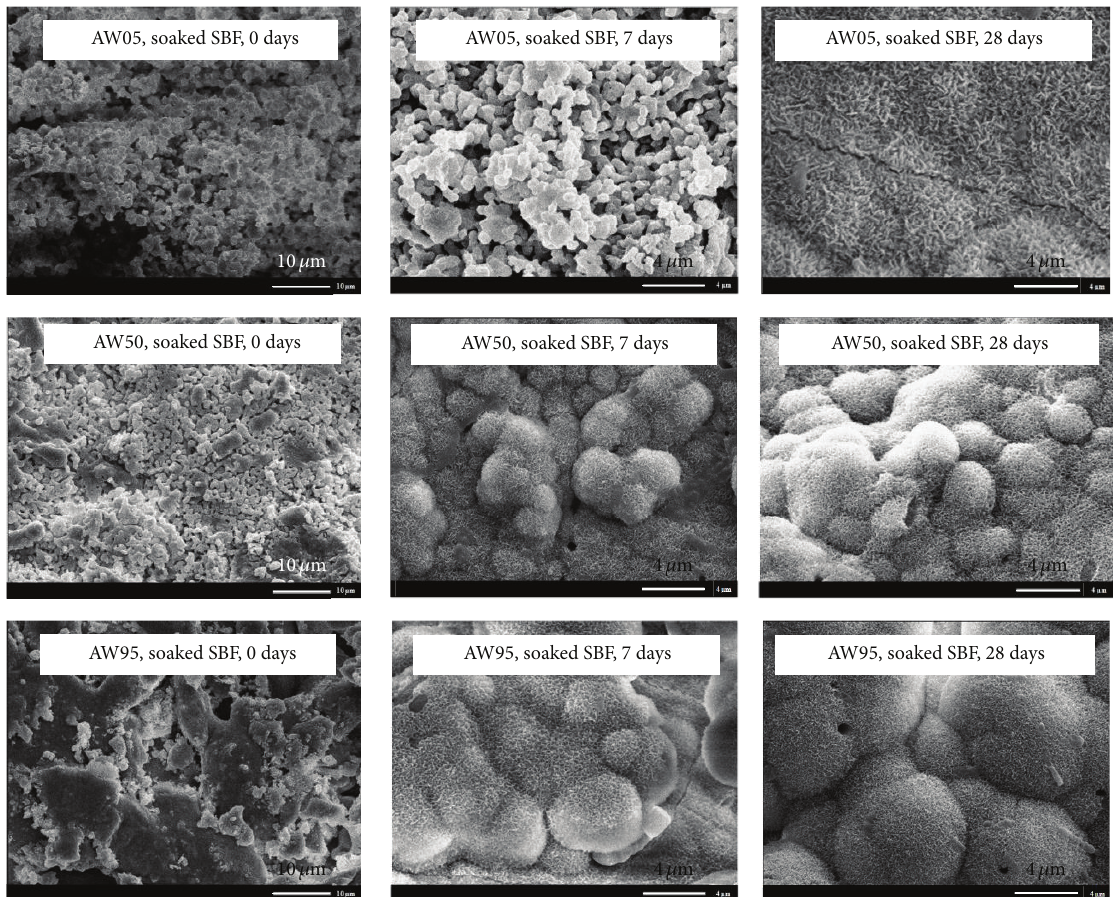
Figure 7: SEM micrographs on the surfaces of HA-AW composites sintered at 1100 ∘ C for 2 h, before and after soaking in the SBF solution at 37 ∘ C for 7 and 28 days.